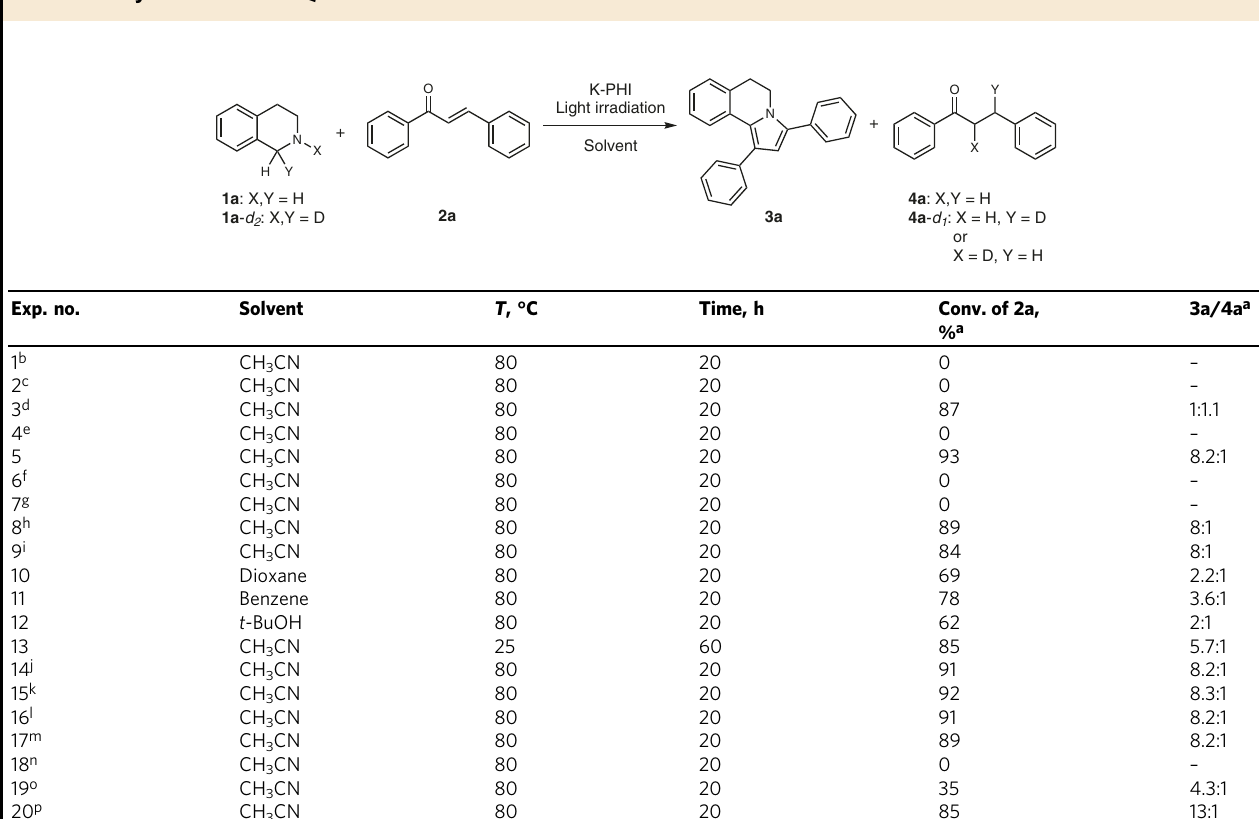
Table 1 Optimization of the reaction conditions of the oxidative condensation between tetrahydroisoquinoline and chalcone 2a toward the synthesis of DHPIQ